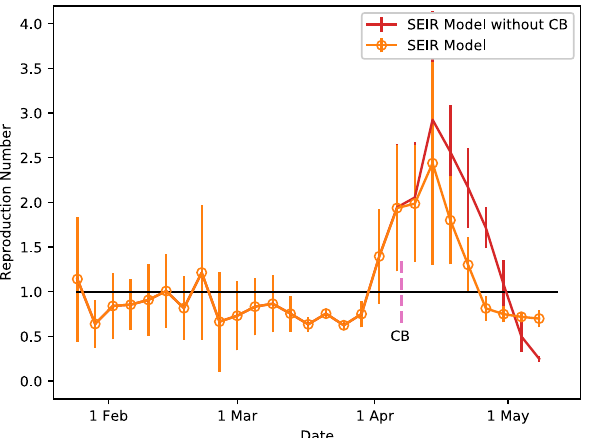
Figure 2. The dynamical evolution of the reproduction number R e derived from the SEIR multiplex model with and without Circuit Breaker (CB) measures. Note that the dashed vertical line marks the beginning of